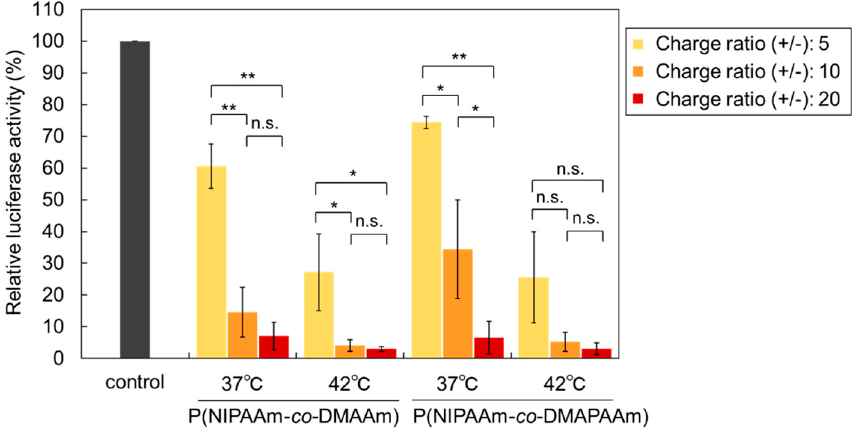
Figure 7. Effect of the charge ratio on the gene silencing activity of Luc-HeLa cells transfected with Luc-siRNA. siRNA was transfected for 4 h at 37 °C or 42 °C using liposomes and lipofectamine RNAiMAX. The data are mean ± standard deviation (SD) ( n = 3 or 4, ** p < 0.01, * p < 0.05, and n.s.: not significant).